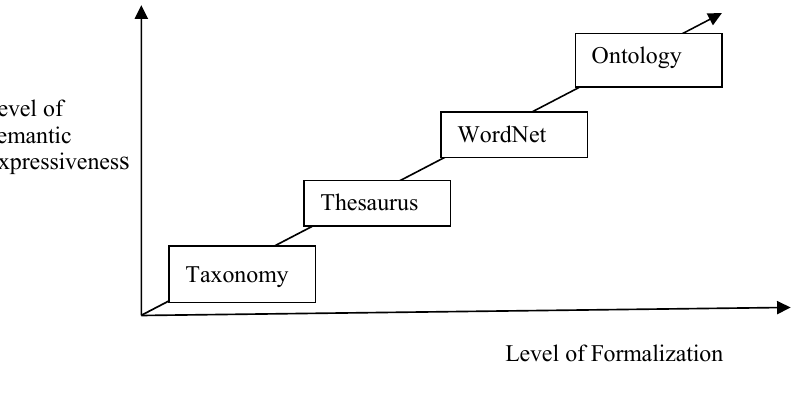
Figure 1. Four types of knowledge structures.